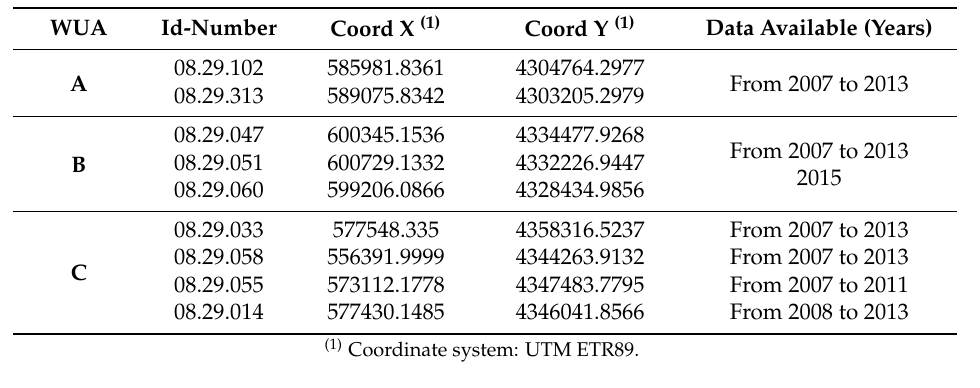
Table 3. Piezometer information for each irrigated area.